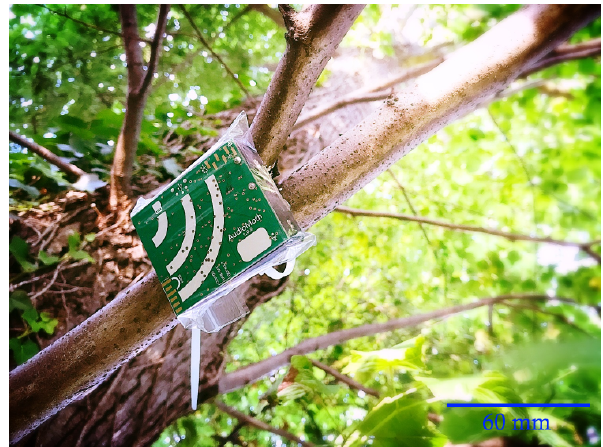
Figure 1. AudioMoth: a low-cost, low-power acoustic monitoring device developed for a wide variety of conservation projects, deployed on a tree in a grip-sealed bag using a cable